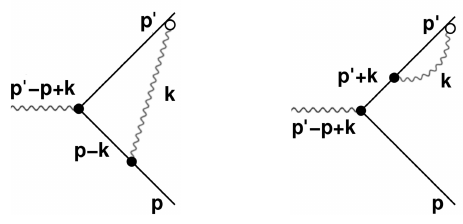
Figure 2 . Two diagrams with “cloud propagators” connecting a vertex operator (“cloud”, open blob) with a QED vertex. Notice that the open blob is attached to one Dirac line, and does not separate two Dirac lines. The cloud propagator only adds the photon momentum to the outgoing infrafield whose Fourier variable is p 0 + k